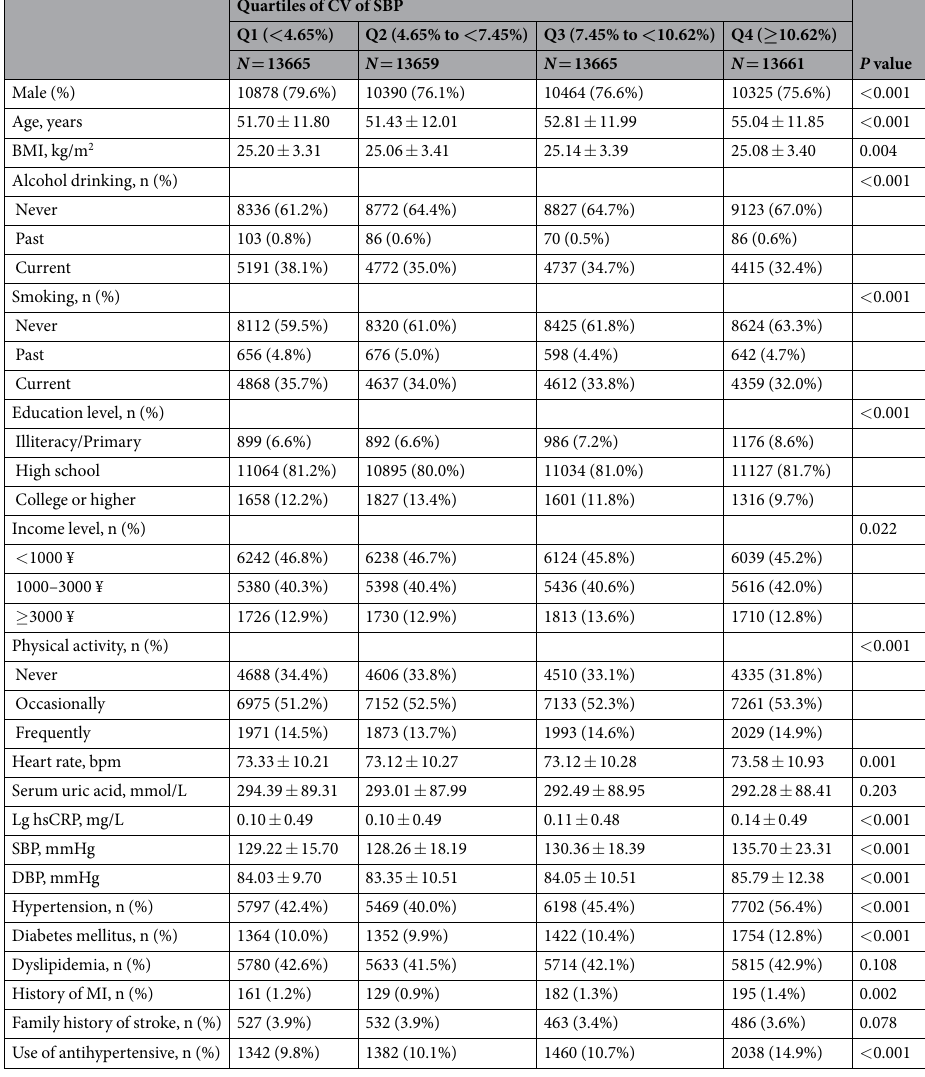
Table 1. Clinical characteristics of the study population according to the quartiles of coefficient of variation of systolic blood pressure. BMI: body mass index; Lg hs-CRP: high-sensitivity C-reactive protein after